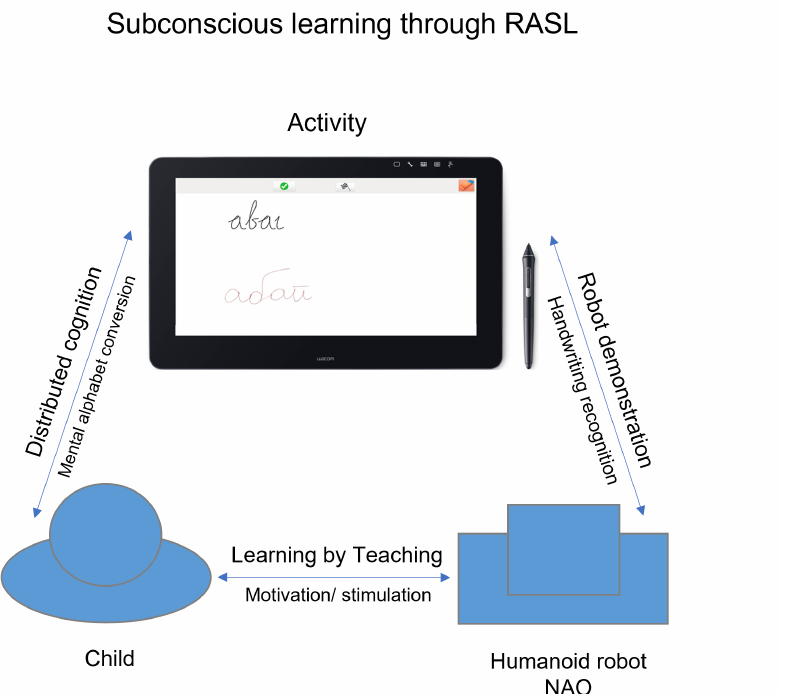
Figure 4. The RASL setup for subconscious